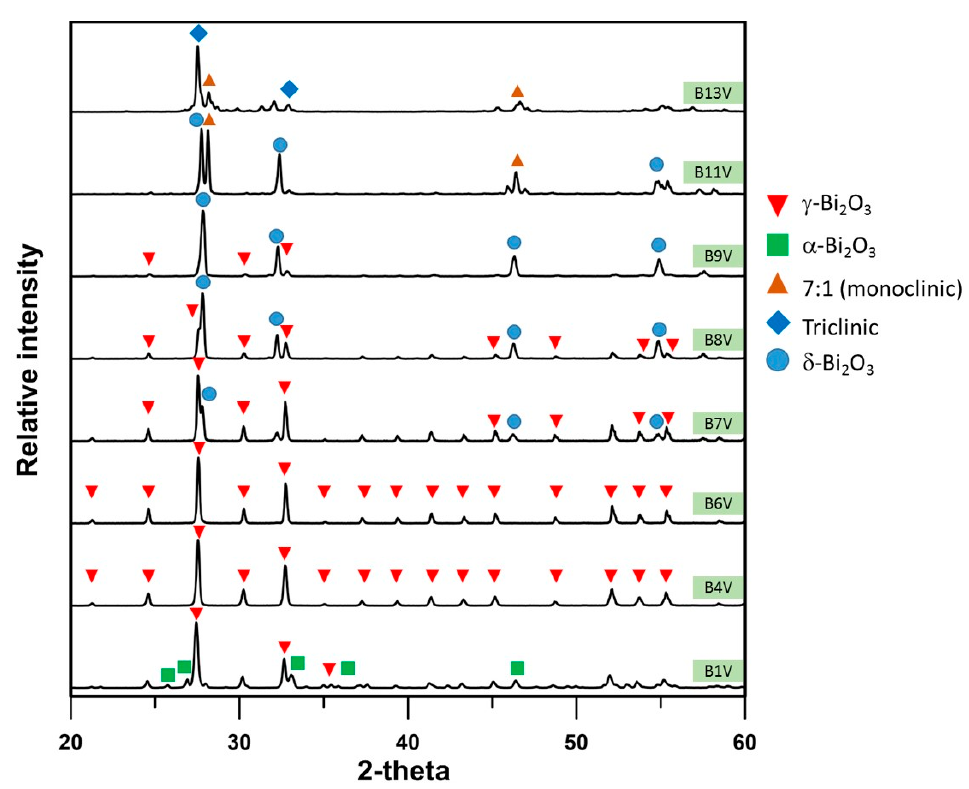
Figure A3. XRD patterns of B1V–B13V die-pressed mixtures, annealed at 800 °C for 100 h.